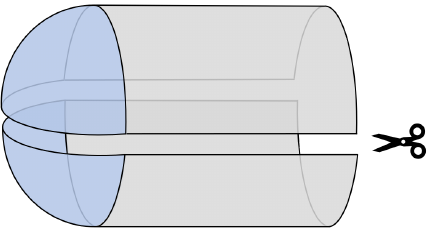
Figure 9. The initial state is prepared by cutting the path integral defined on the